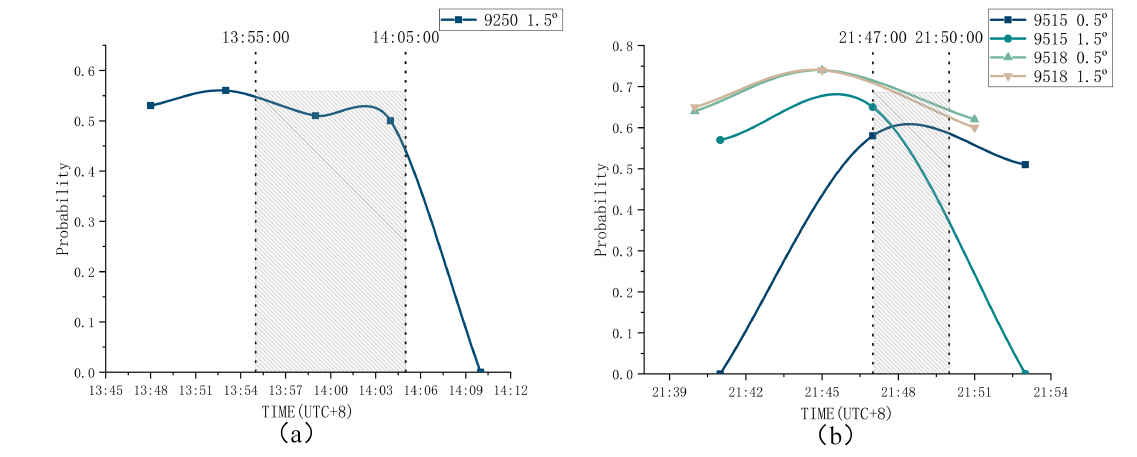
Figure 13. The change of probability in the results of the third tornado case with time. ( a ): Tornado case on 12 June 2020. ( b ): Tornado case on 22 July 2020. (When TDA-RF does not recognize a tornado, the probability is set to 0. The shaded area is the tornado